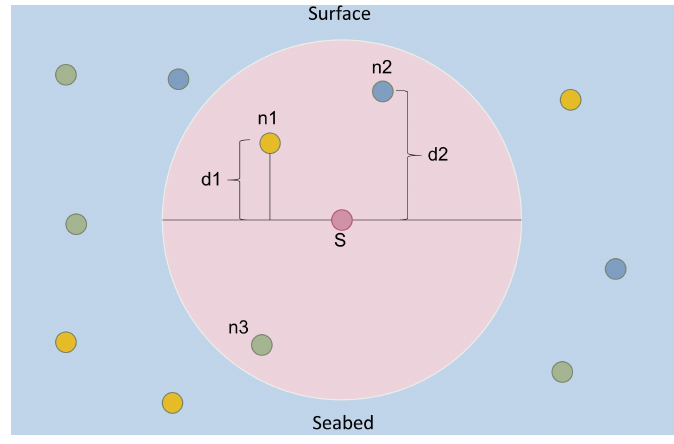
Figure 4. Routing Technique of Depth Based Routing (DBR)